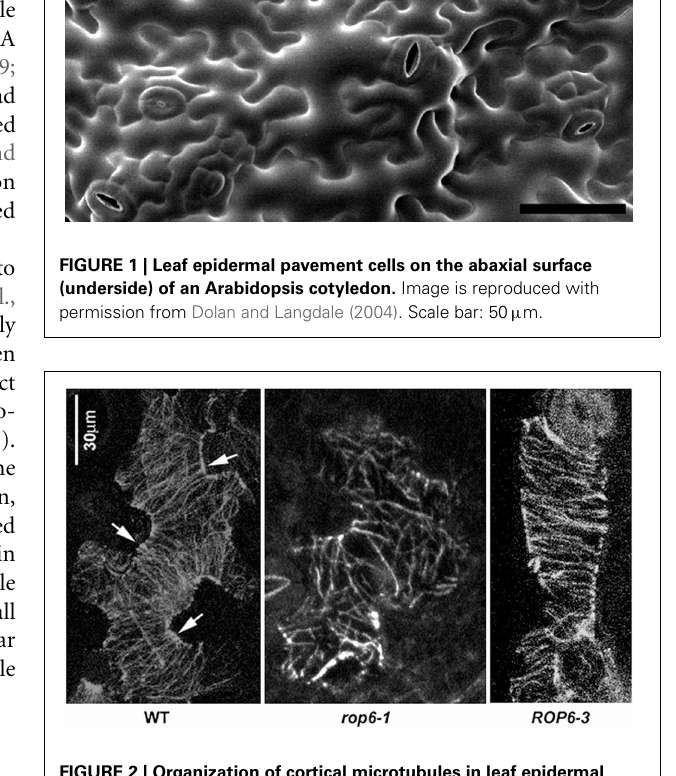
FIGURE 2 | Organization of cortical microtubules in leaf epidermal pavement cells. Typical organization of microtubules in wild-type (left panel), rop6-1 (mid panel) and ROP6-3 over-expressor (right panel) leaf epidermal pavement cells visualized by an anti-tubulin antibody. Arrows indicate ordered transverse microtubules in the neck regions of wild-type cells. Image is reproduced with permission from Fu et al. (2009). Scale bar: 30 μ